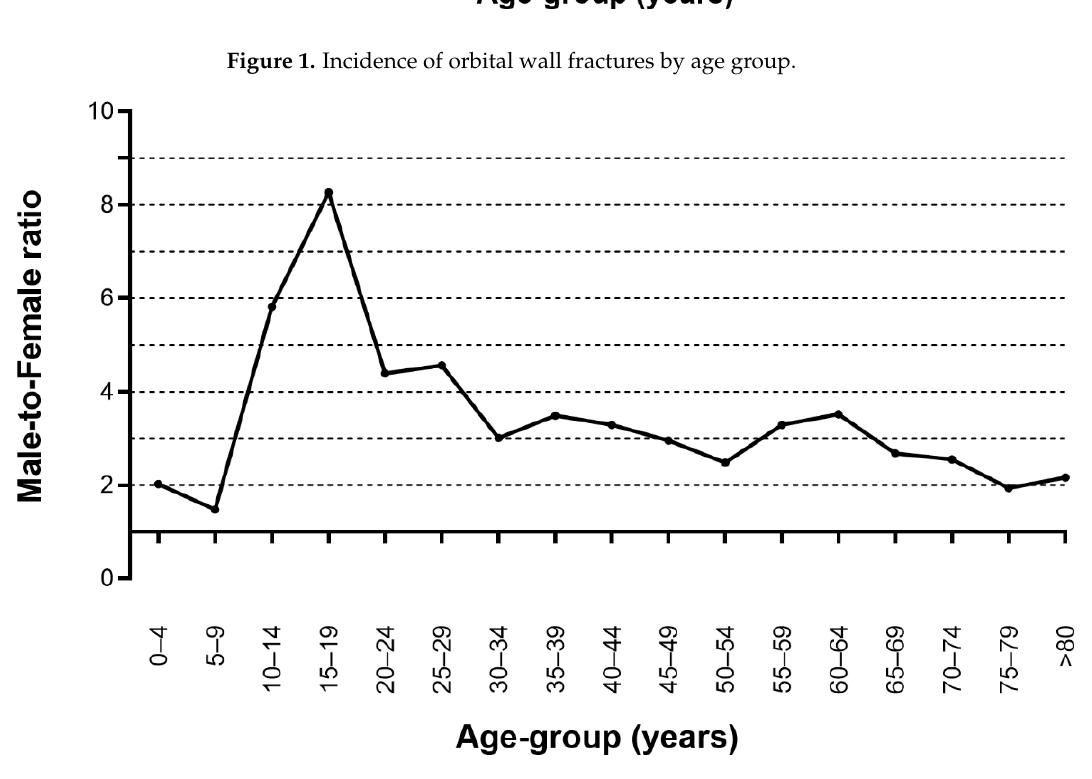
Figure 2. Male-to-female ratio for the incidence of orbital wall fractures.